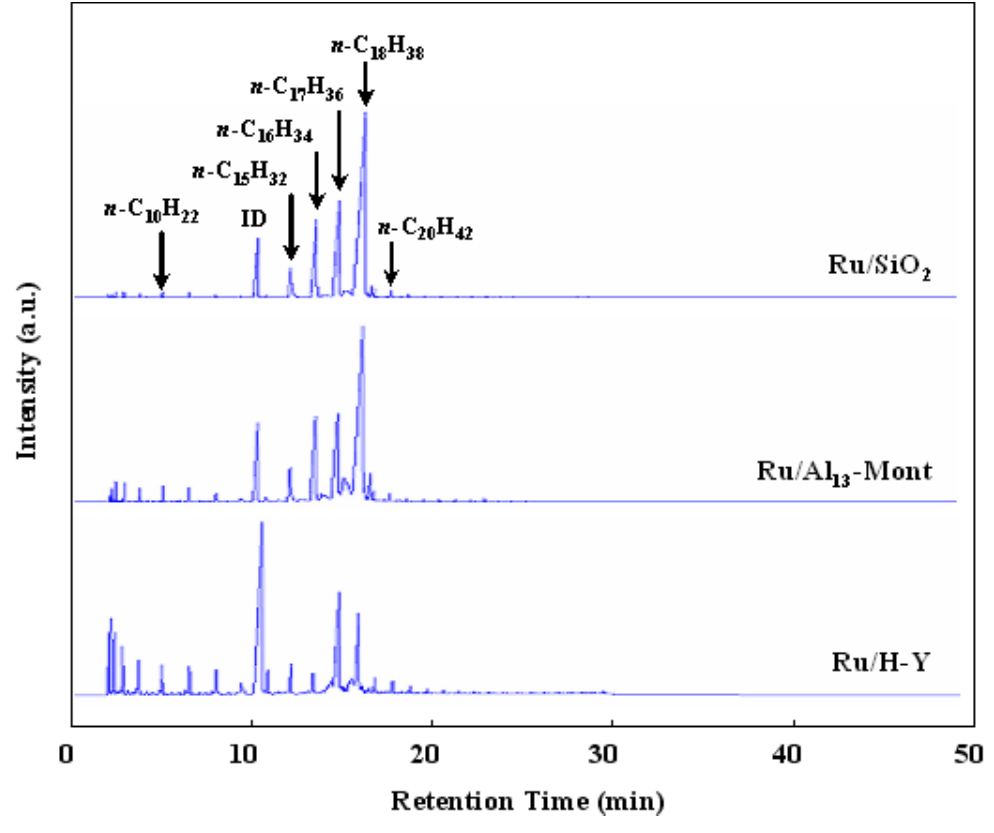
Figure 4. FID-GC charts of liquid hydrocarbons formed from the hydrotreatment of waste cooking oil over various catalysts (reaction conditions: same as those in Table 4).